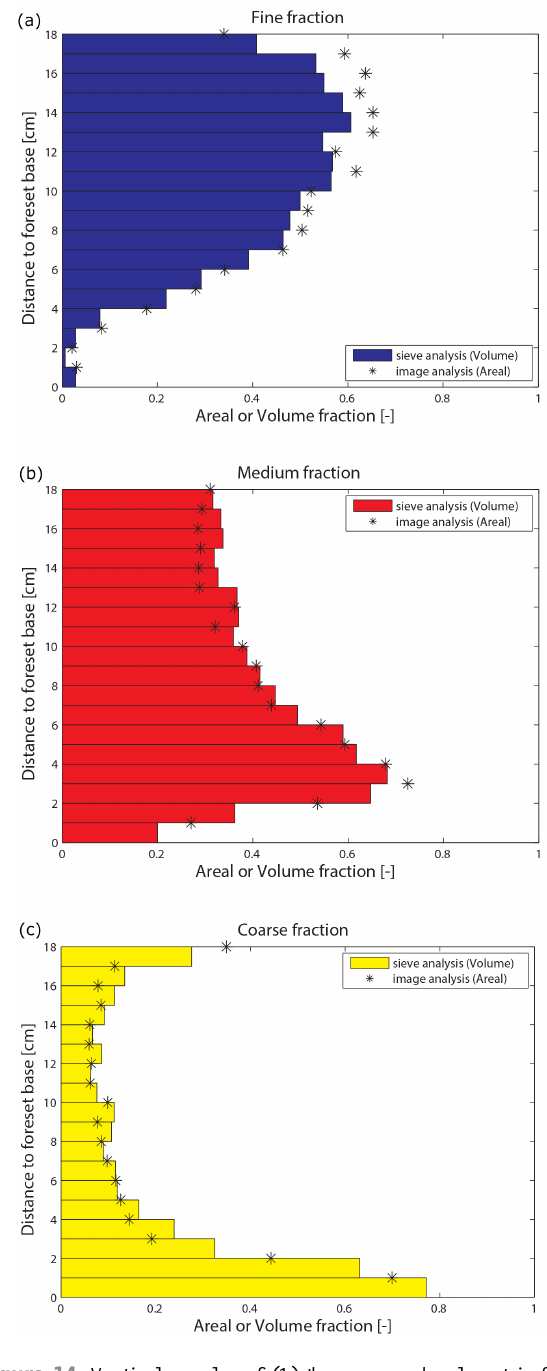
Figure 14. Vertical profiles of (1) the measured volumetric frac- tion contents measured through sieve analysis and (2) the areal frac- tion contents determined through image analysis for each grain-size fraction: (a) fine, (b) medium, and (c) coarse for Experiment E1, centre